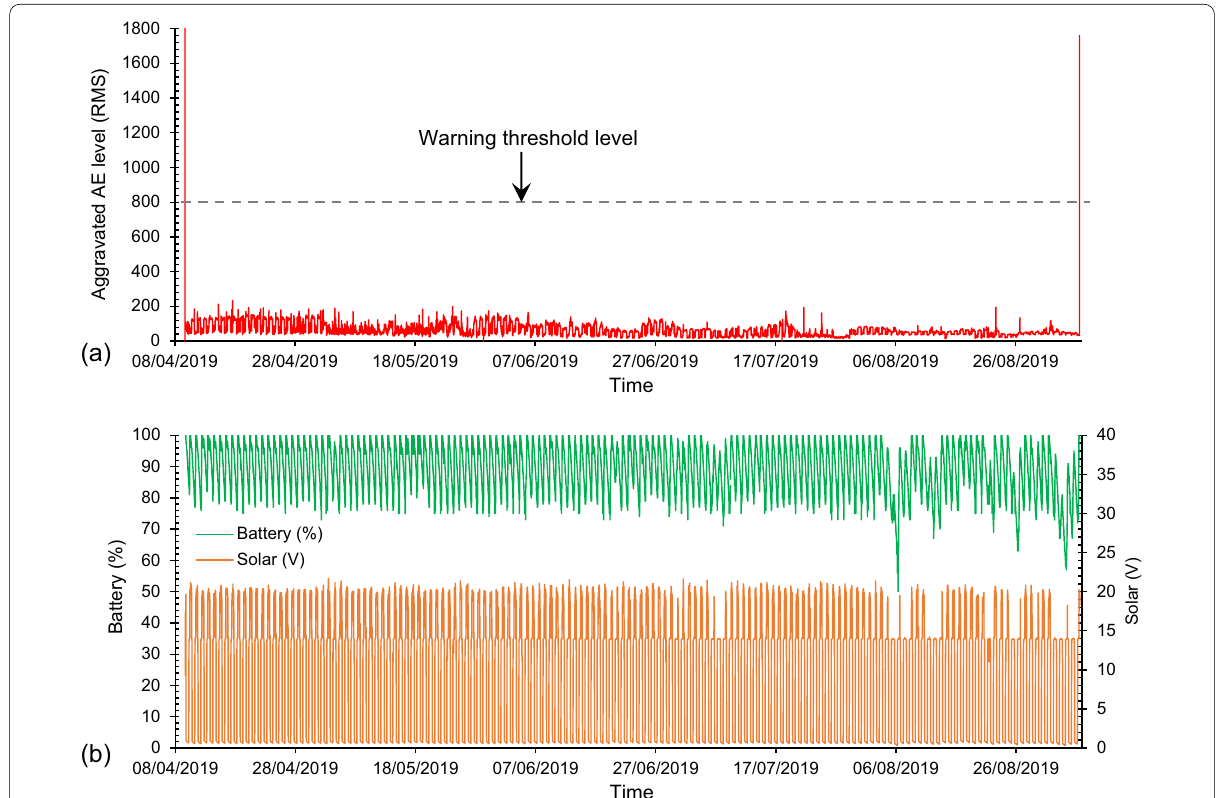
Fig. 8 Site 2, Sensor 3 a Example measured AE data showing low level aggregated AE RMS time series measurements indicative of stable ground. The peaks of AE at the start and end of the monitoring period were generated by CCERR/LRV visiting the site to trigger an alert and test operation of the system. b shows example solar (V) and battery level (%) data. (Dixon and Smith